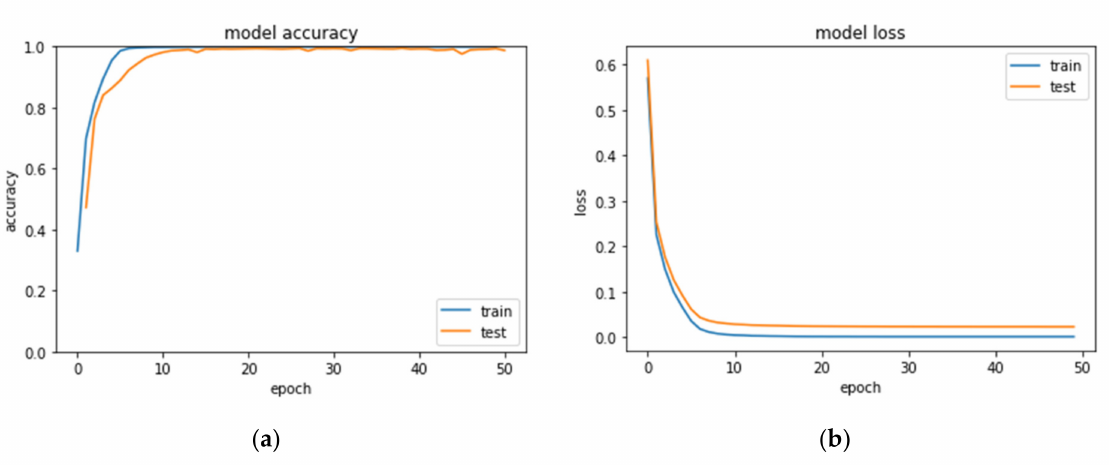
Figure 8. Accuracy Curve ( a ) and Loss Curve ( b ) of our proposed MalCaps model trained on the MMCC dataset.